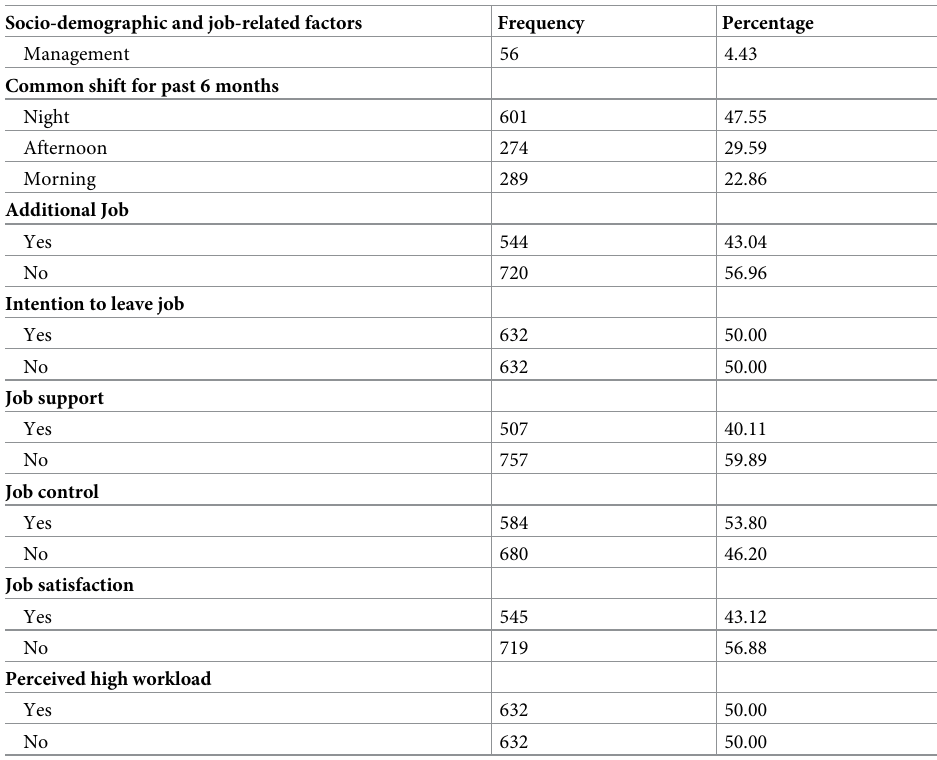
displayed higher depersonalization. The results showed that participants from the primary level hospital had the highest level of high emotional exhaustion and depersonalization. In contrast, the level of low personal accomplishment was highest in the tertiary level hospital (Table 2).